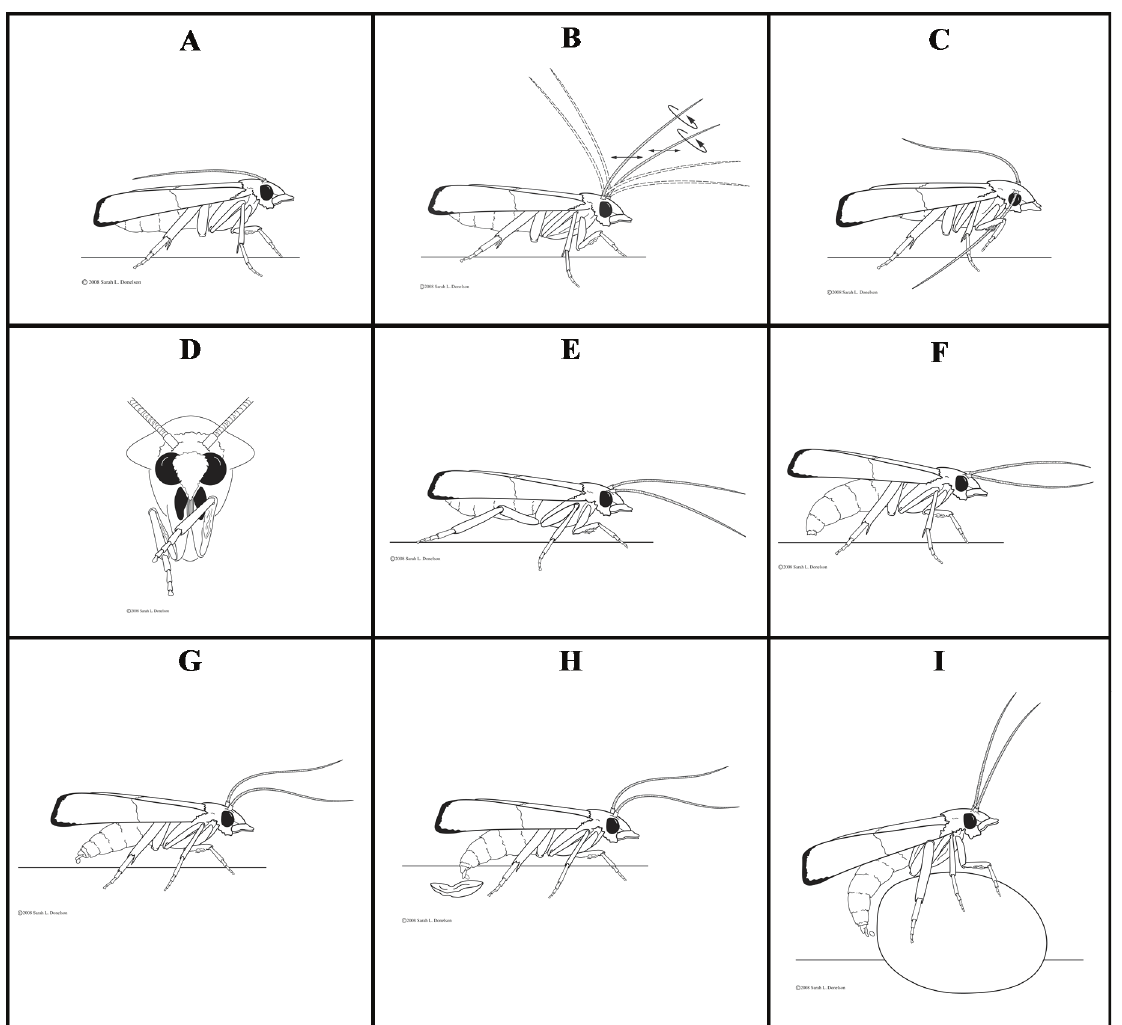
Figure 2. A generalized depiction of the sequence of behaviors displayed by gravid Plodia interpunctella females before and during oviposition that include ( A ) resting; ( B ) antennal movement; ( C ) grooming of antenna; ( D ) grooming of mouthparts; ( E ) walking; ( F ) abdomen bending and dragging; and ( G – I ) oviposition.